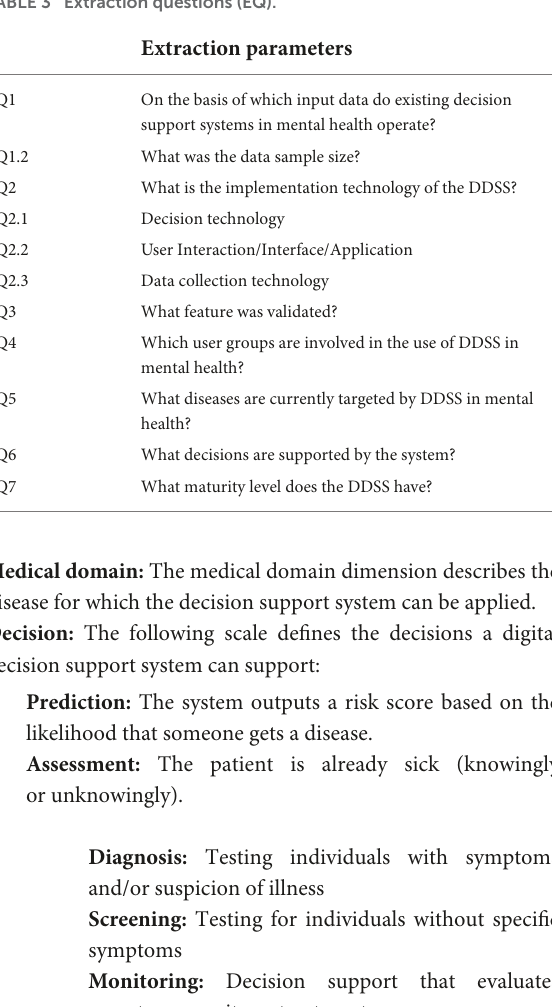
TABLE 3 Extraction questions (EQ).